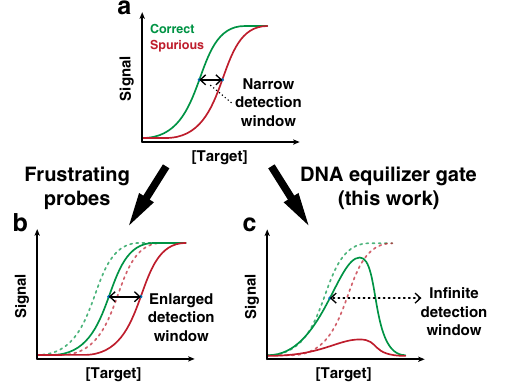
Fig. 1 Detection windows for discriminating single nucleotide